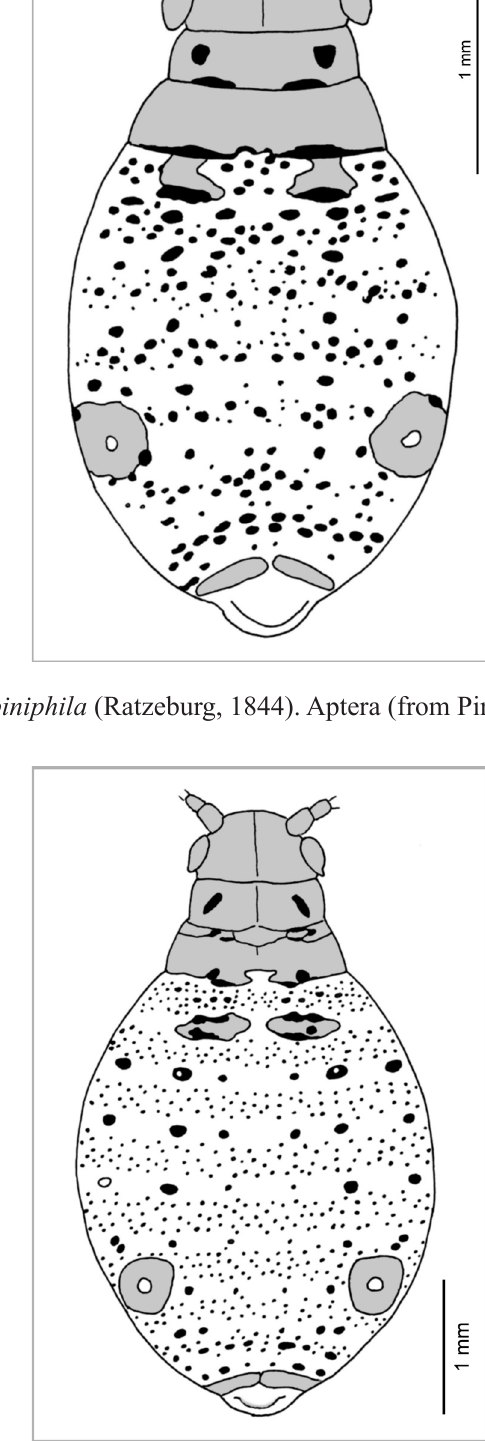
Fig. 106. Cinara (Cinara) schimitscheki Börner, 1940. Aptera (after Pintera 1966, redrawn).